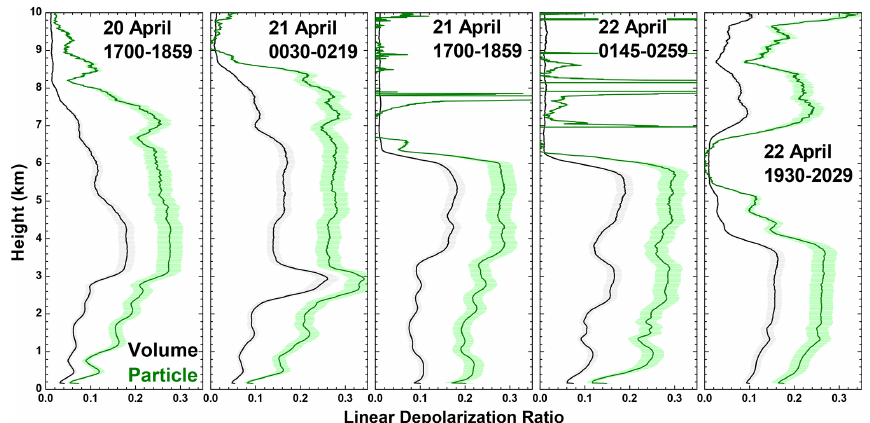
Figure 2. Profiles of the linear volume depolarization ratio (black line with grey error range) and the particle linear depolarization ratio (dark green line with light green error range) measured by the Polly XT lidar around the times (see Table 1) of the UCASS launches marked in Fig. 1.